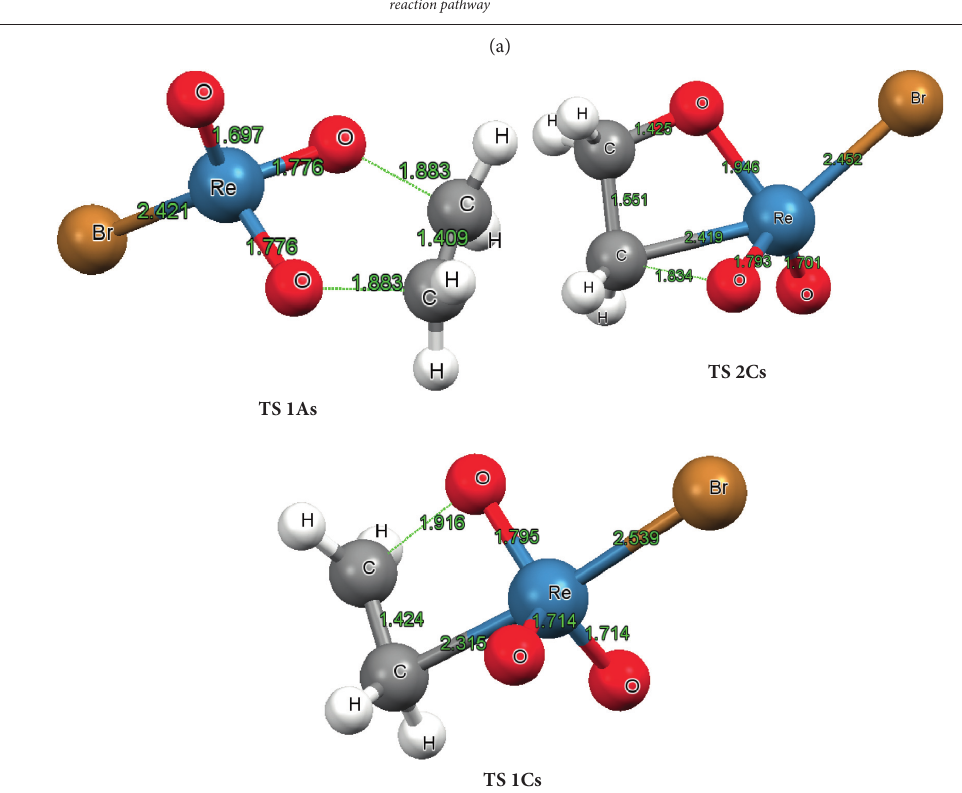
∗ level of theory. (b) 3 Br and ethylene at the B3LYP/LACVP